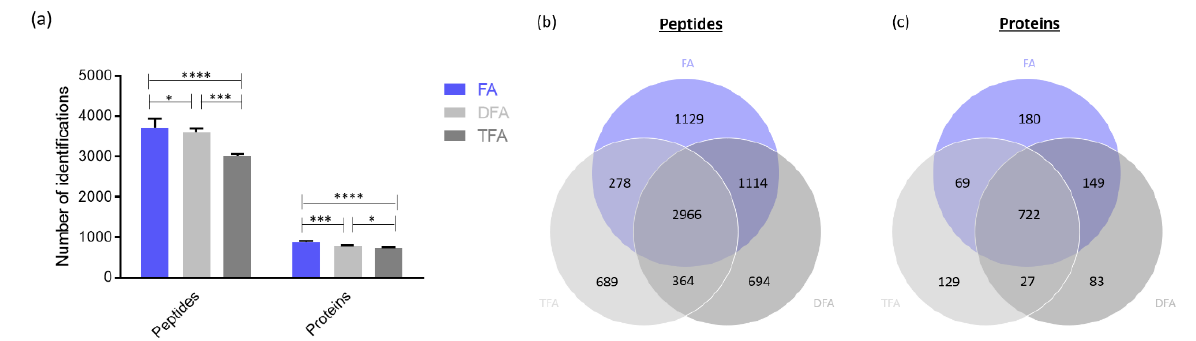
Figure 2. ( a ) Number of peptides and proteins identified with the different acidic modifiers: FA, DFA, TFA. (mean ± SD ( n = 3)) * represents p -value < 0.05; *** ( p -values < 0.001) and **** ( p -value < 0.0001); ( b ) Venn diagram representing the number of peptides identified with FA, DFA or TFA in sample- loading mobile phase and the sample resuspending solvent (pool of three runs); ( c ) Venn diagram representing the number of proteins identified with FA, DFA or TFA in the sample-loading mobile phase and the sample resuspending solvent (pool of three runs). Analytical column: 2 m µ PAC. Sample: 1 µ g Pierce™ HeLa Protein Digest